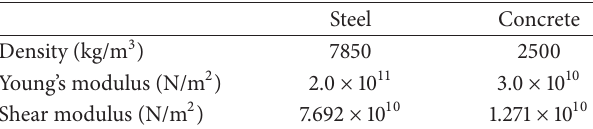
Table 3: Properties of